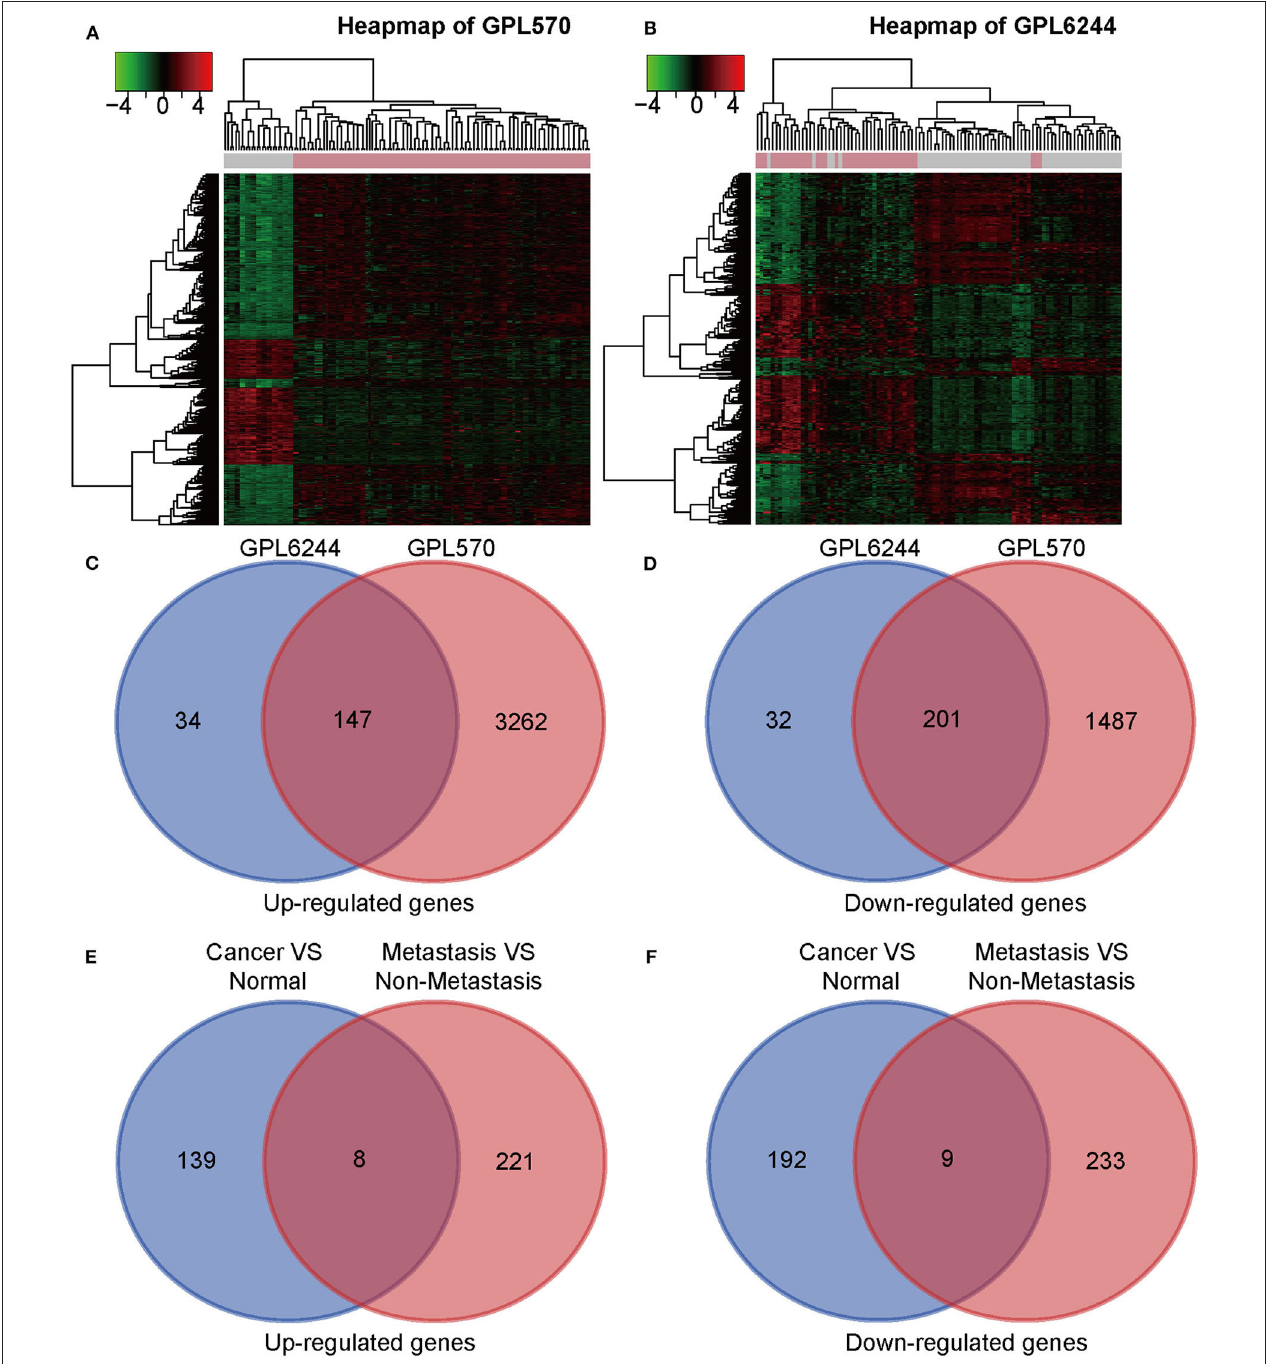
FIGURE 2 | Identification of differentially expressed genes (DEGs). (A,B) Heat map of DEGs on the basis of GPL6224 and GPL570 in the integrated microarray analysis. Each column represents one sample, and each row represents one gene. The color spectrum ranging from green to red represents the range of downregulation or upregulation. Each column represents one sample, and each row represents one gene. (C,D) Venn diagrams of the upregulated and downregulated DEGs between the datasets based on GPL6224 and GPL570. (E) A total of 147 genes were found to be upregulated in triple-negative breast cancer (TNBC) tissues compared with normal breast tissue. A total of 229 genes were found to be upregulated in metastatic TNBC tissues compared with normal breast tissue. With the use of a Venn diagram, eight genes were found to overlap between the two gene sets ( SQLE , RASD2 , SDC1 , CXADR , SPP1 , MMP11 , S100A7 , and S100P ). (F) A total of 201 genes were found to be downregulated in TNBC tissues compared with normal breast tissue. A total of 242 genes were found to be downregulated in metastatic TNBC tissues compared with normal breast tissue. With the use of a Venn diagram, nine genes were found to overlap between the two gene sets ( GIPC2 , CX3CR1 , TPRG1 , IGSF10 , RBMS3 , TGFBR2 , RNF125 , LIFR , and COL6A6 ).